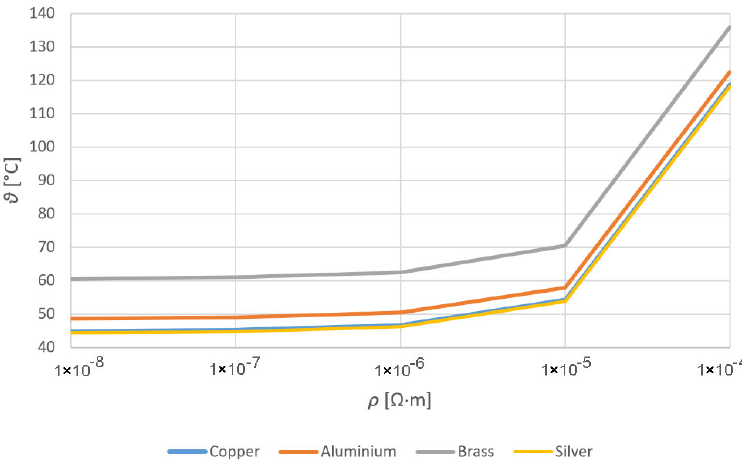
Figure 11. Temperature dependence of impurity resistivity for considered materials in the center of contact.